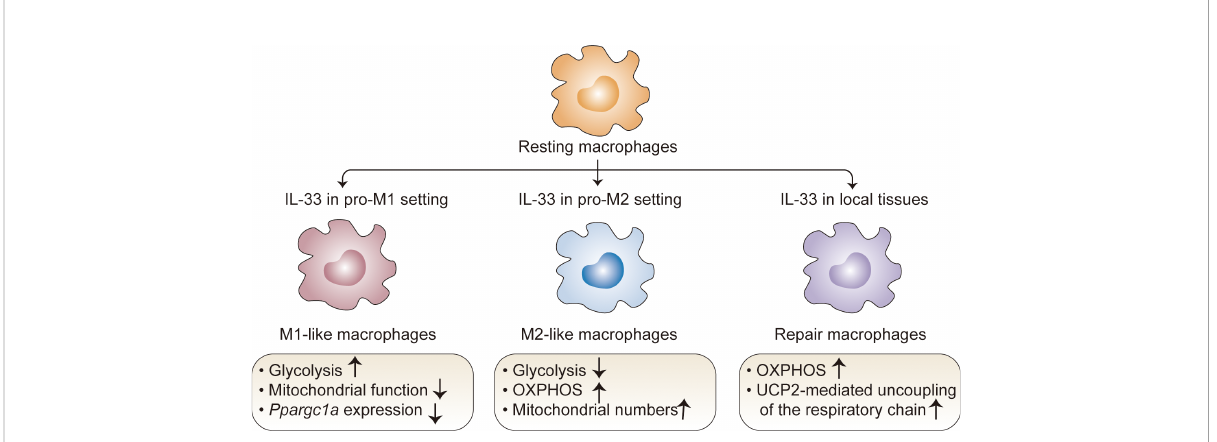
FIGURE 3 Regulation of macrophage metabolism by IL-33. In the pro-M1 setting, IL-33 drives glycolysis and decreases mitochondrial function; in the pro- M2 setting, IL-33 decreases glycolysis but increases OXPHOS. IL-33 alone directs macrophages toward a M2-like state, which mainly use OXPHOS to increase basal respiration and ATP production; in this context, UCP2-mediated uncoupling of the respiratory chain plays a critical role, which blocks the generation of ROS and allows sustained mitochondrial respiration and an intact TCA cycle. OXPHOS, oxidative phosphorylation; TCA, tricarboxylic acid; UCP2, uncoupling protein